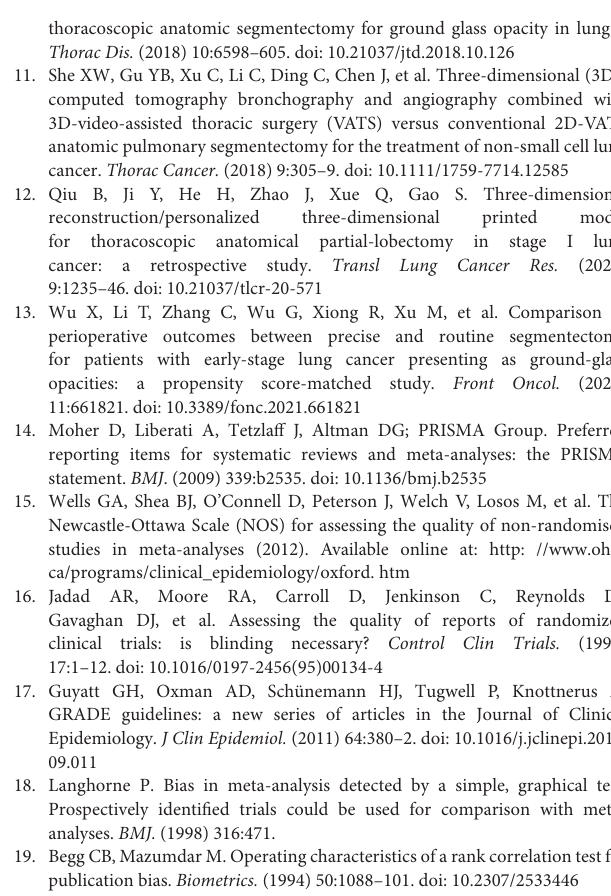
Supplementary Table 1 | PRISMA 2009 Checklist. Supplementary Table 2 | The strategy of searching. Supplementary Table 3 | GRADE quality assessment of the results through treatment strategy and research